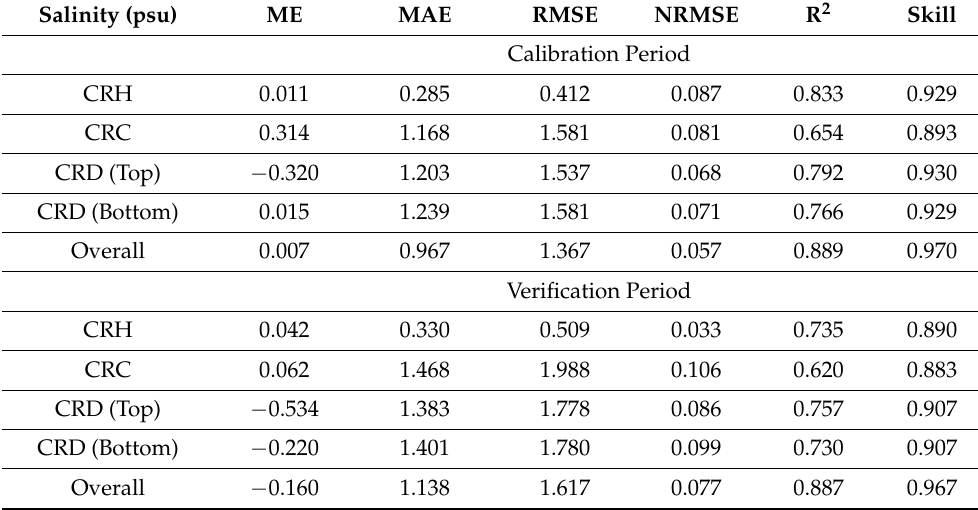
Table 3. MEs, MAEs, RMSEs, NRMSEs, R 2 values, and skills for simulated salinities (psu) in comparison with real-time field data measured at the CRH, CRC, and CRD stations during the calibration period, the verification period, and the entire simulation